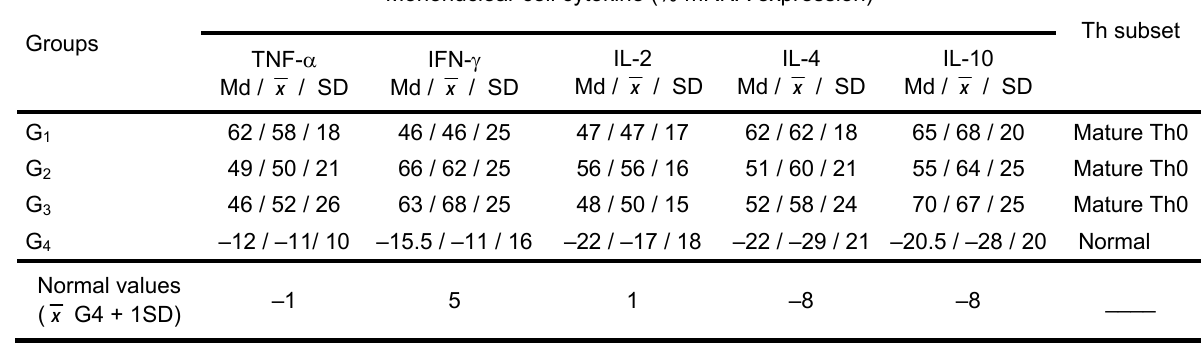
Table 3. Distribution of mononuclear cell cytokine values by group